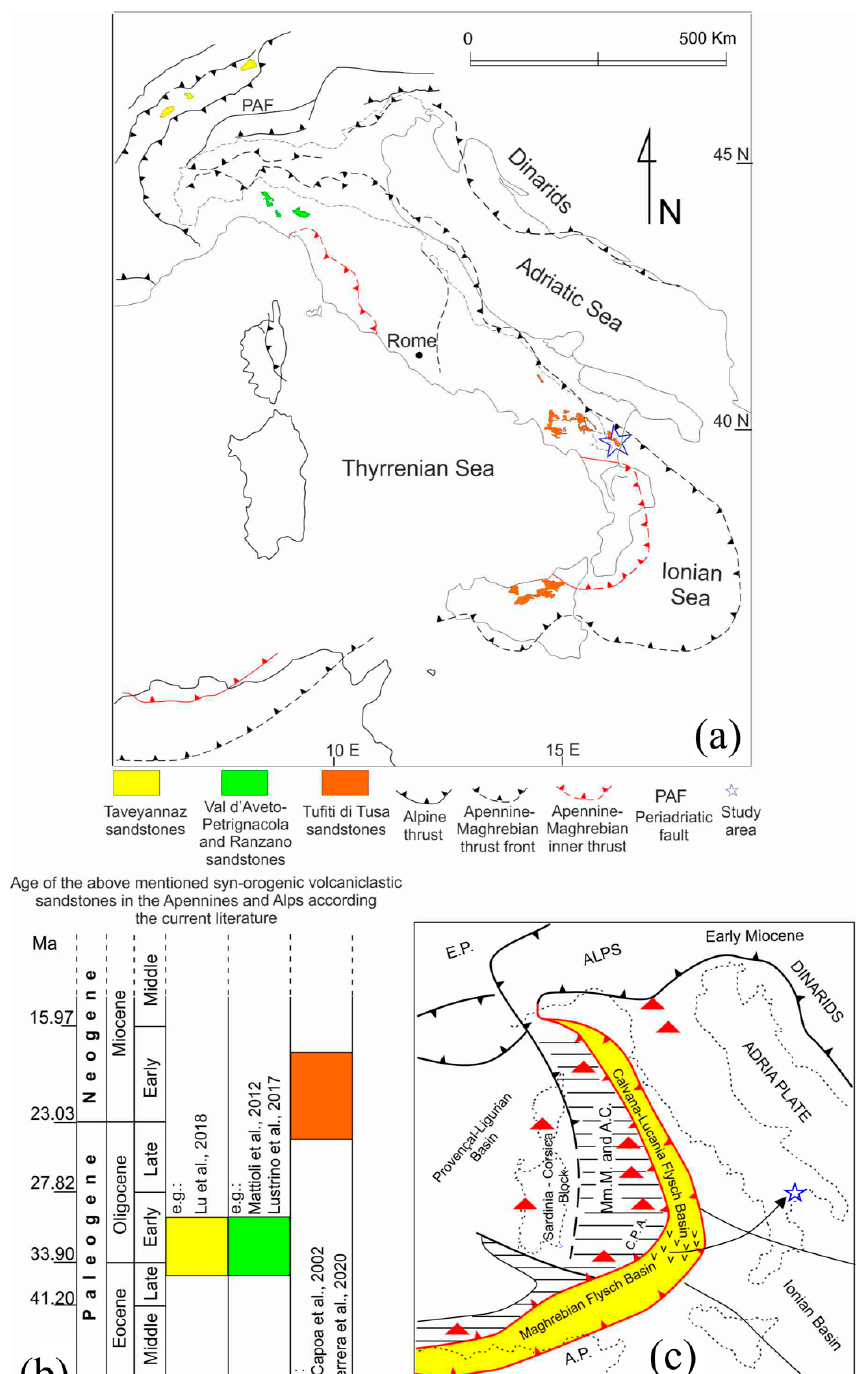
Figure 1. ( a ) Distribution of the main volcaniclastic turbidite deposits in the northern external sector of the Western Alps, in the inner sector of the Northern and Southern Apennines and in Sicily (Italy). The blue star indicates the study area. ( b ) Age of the above-mentioned volcaniclastic sandstones according to the current literature. ( c ) Paleogeographic and paleotectonic sketch of the Apennine-Maghrebian foredeep basin system in the Western-Central Mediterranean area in the Early Miocene. Symbols “vvv” represent the depositional domain of volcaniclastic sandstones; blue star is the geographical location of the studied outcrops (modified from [2,20]). Mm.M., Mesomediterranean Microplate; A.C., Alpine Chain; E.P., European Plate; A.P., African Plate; C.P.A., Calabria-Peloritani Arc.